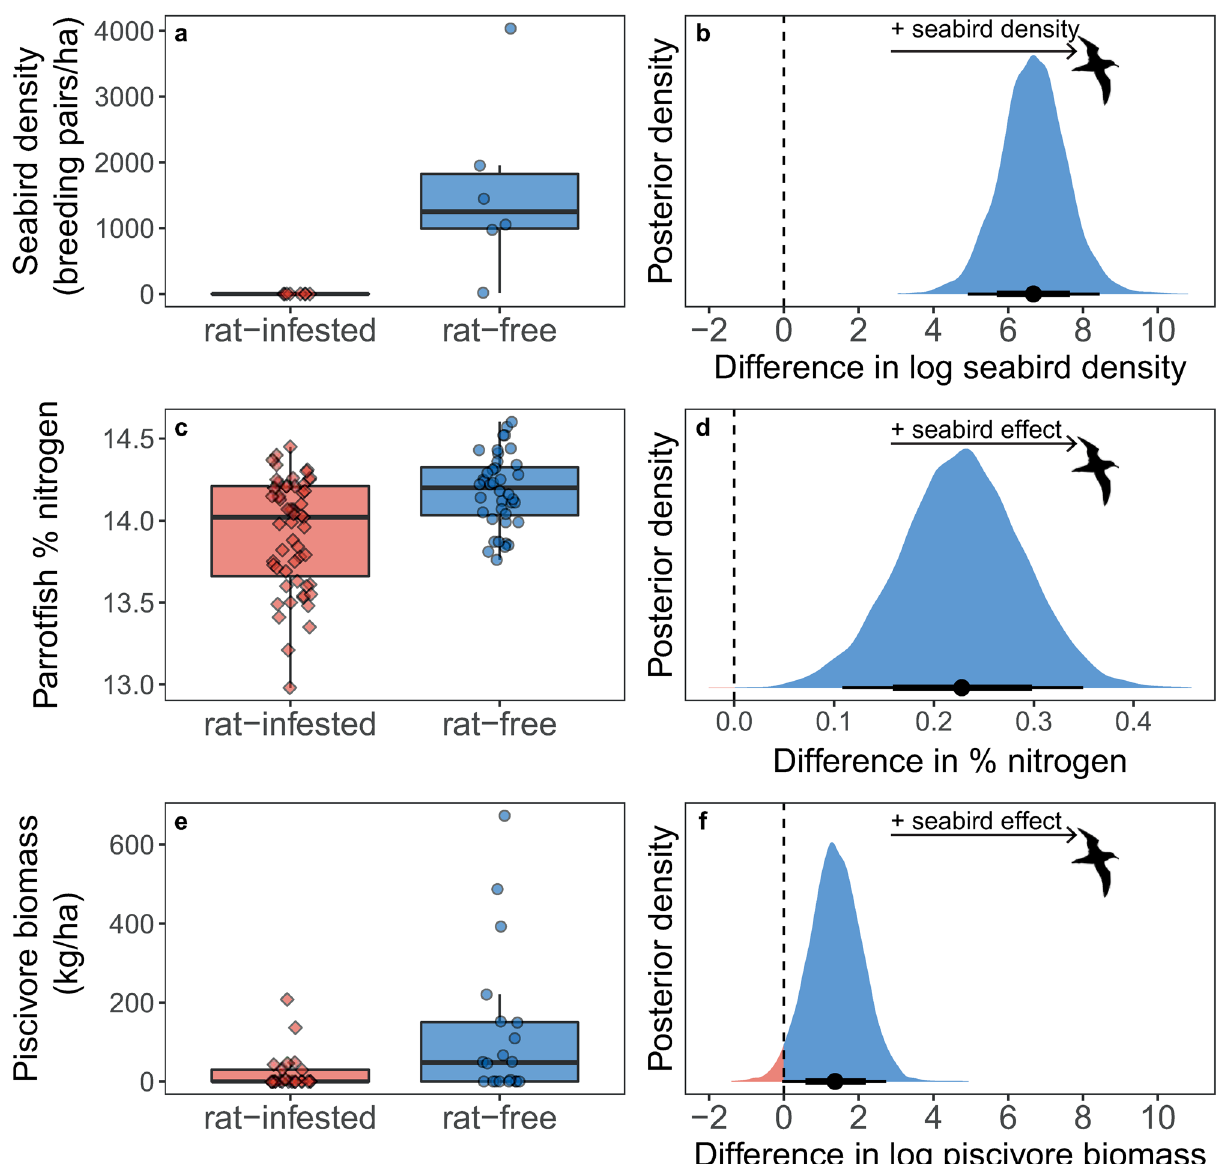
Figure 3. Potential drivers of demographic differences in Chlorurus sordidus around rat-free islands with abundant seabirds (blue, circles) compared to rat-infested islands with few seabirds (red, diamonds). ( a , c , e ) Box limits represent first and third quantiles (25% and 75% percentiles), middle line represents the median (50% percentile), and whiskers represent smallest and largest observations less than or equal to 1.5 × inter- quartile range. Each point represents ( a ) an island, ( b ) measured values from an individual C. sordidus , or ( c ) a transect. ( b , d , f ) Bayesian posterior densities for the effect of seabird presence on the corresponding responses in ( a , c , e ). Positive values of the posterior distributions (blue fill) indicate a positive effect of seabird presence on the response, negative values (red fill) indicate a negative effect of seabirds (i.e., positive effect of invasive rat presence). Points represent median highest posterior density estimate and lines represent 75% and 95% highest posterior distribution intervals (HPDI). Rat and seabird silhouettes were obtained from phylopic.org under Public Domain Dedication 1.0